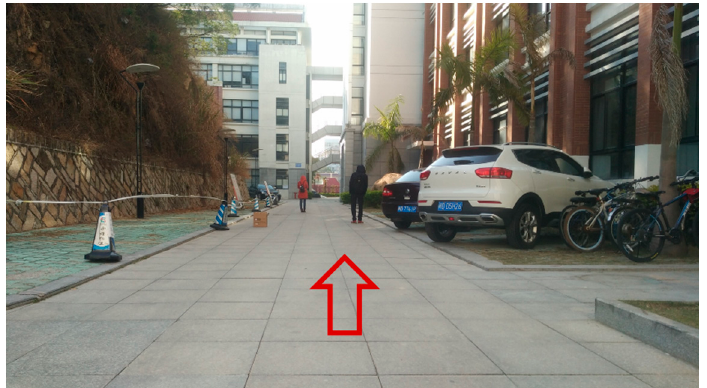
Figure 6. Scene 1—normal road.